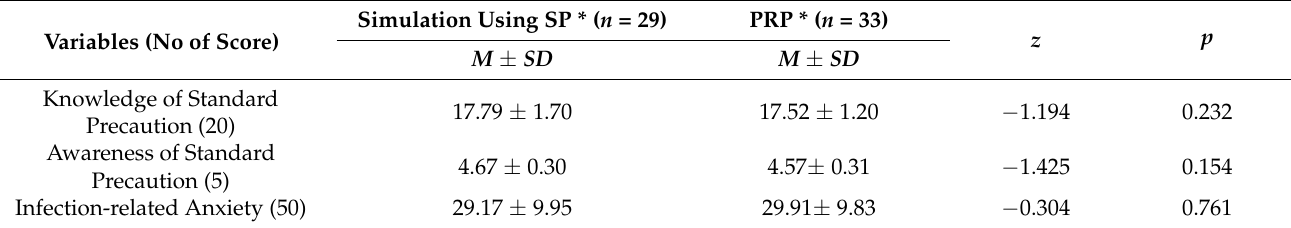
Table 3. Homogeneity of the variables between two groups.